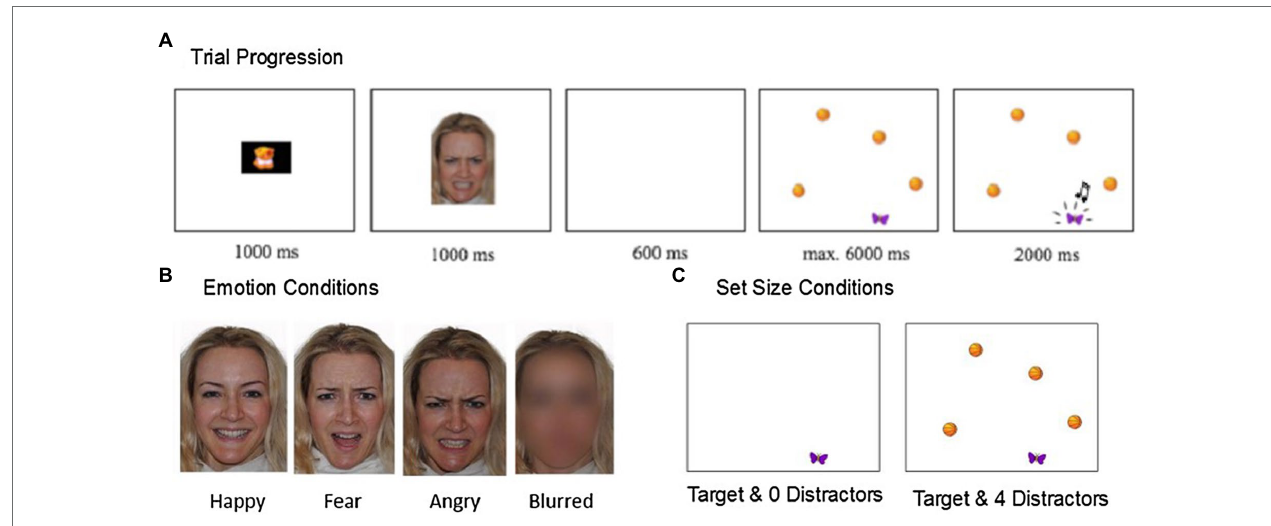
FIGURE 2 | (A) Trial Progression (B) Emotion Conditions (C) Set Size